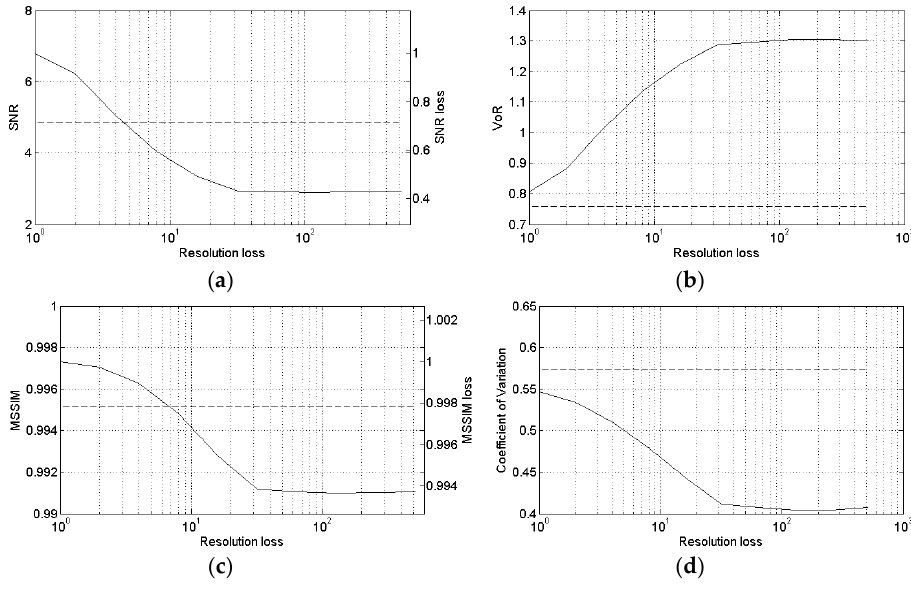
Figure 10. Sensitivity of SB-SARBM3D against the DEM resolution loss: ( a ) SNR; ( b ) VoR; ( c ) MSSIM; ( d ) coefficient of variation. The highest resolution ensures the best performance; SARBM3D (dashed lines).